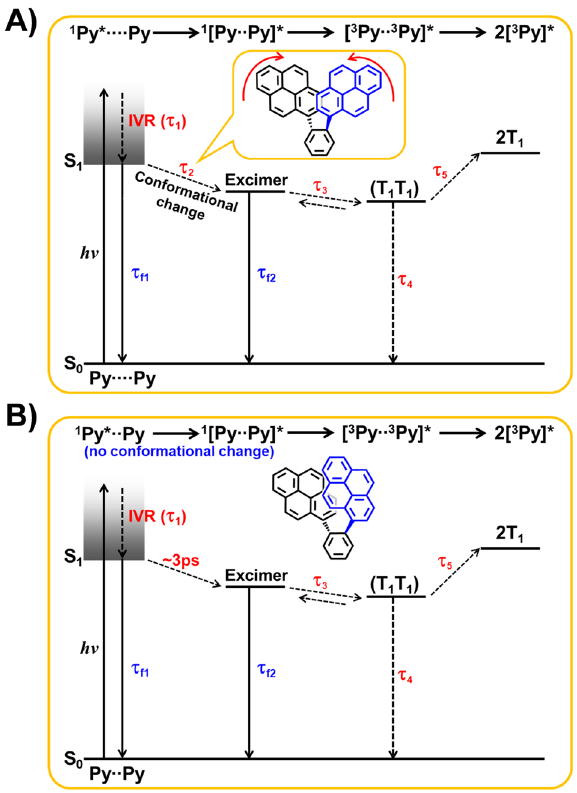
Fig. 7 Schematics for proposed relaxation dynamics of Anti -DPyB and Syn -DPyB. Excited-state relaxation dynamics of A Anti -DPyB and B Syn - DPyB. IVR stands for intramolecular vibrational